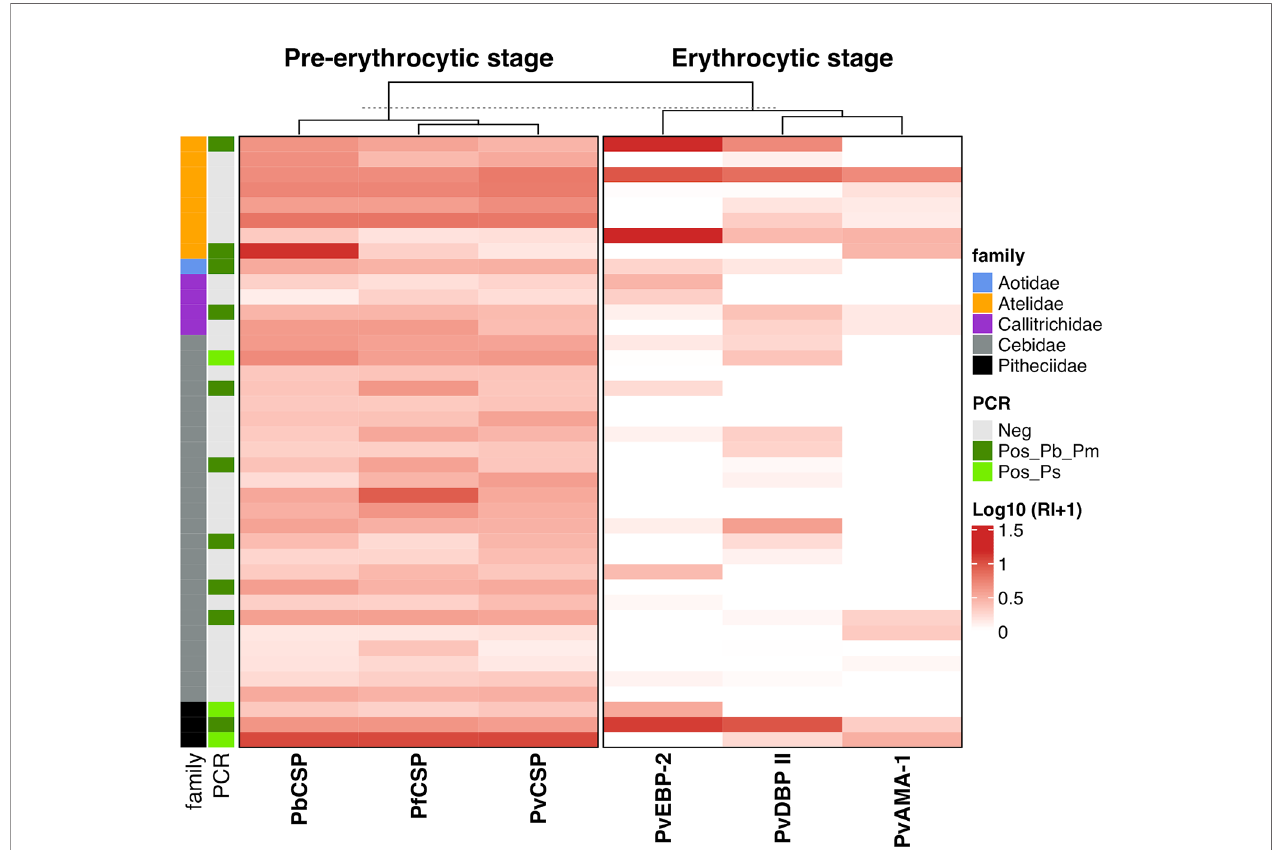
FIGURE 6 | Heatmap of antibody levels against Plasmodium antigens among monkeys from Platyrrhni families. IgG antibody levels against CSP repeats from different Plasmodium species and Plasmodium vivax erythrocytic antigens among Platyrrhni families from Guapimirim/RJ. Antibody response IgG was expressed as Log10 Reactivity Index (RI+1). RI values increase with more intense red color. PvCSP: CSP repeats representing P. vivax CSP repeats (VK210, VK247, and P. vivax - like); Pb/PmCSP: CSP repeat of P. brasilianum/P. malariae ; PfCSP: CSP repeat of P. falciparum ; PvAMA-1: P. vivax Apical Membrane antigen – 1; PvEBP-2: P. vivax Erythrocyte Binding Protein 2; PvDBPII: P. vivax Duffy Binding Protein region II. Animals positive for Plasmodium by PCR (light green square – P. simium ; dark green square - P. brasilianum/P. malariae ) or negative – grey